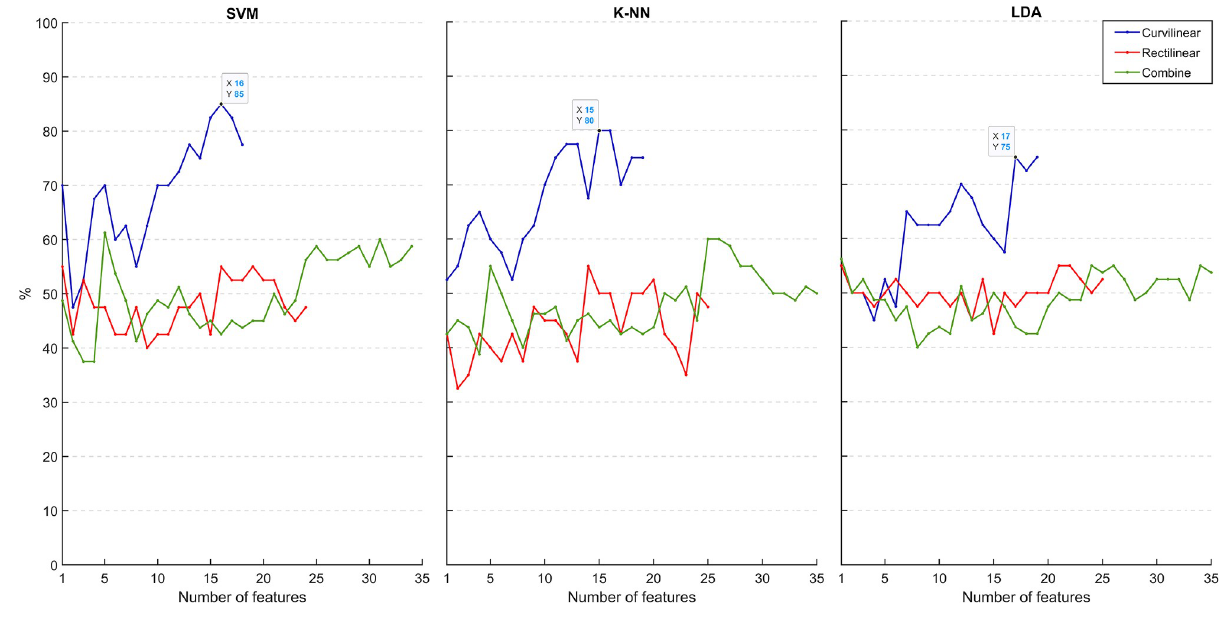
Fig 4. Dependence of % classification accuracy on the number of features selected by NCA.